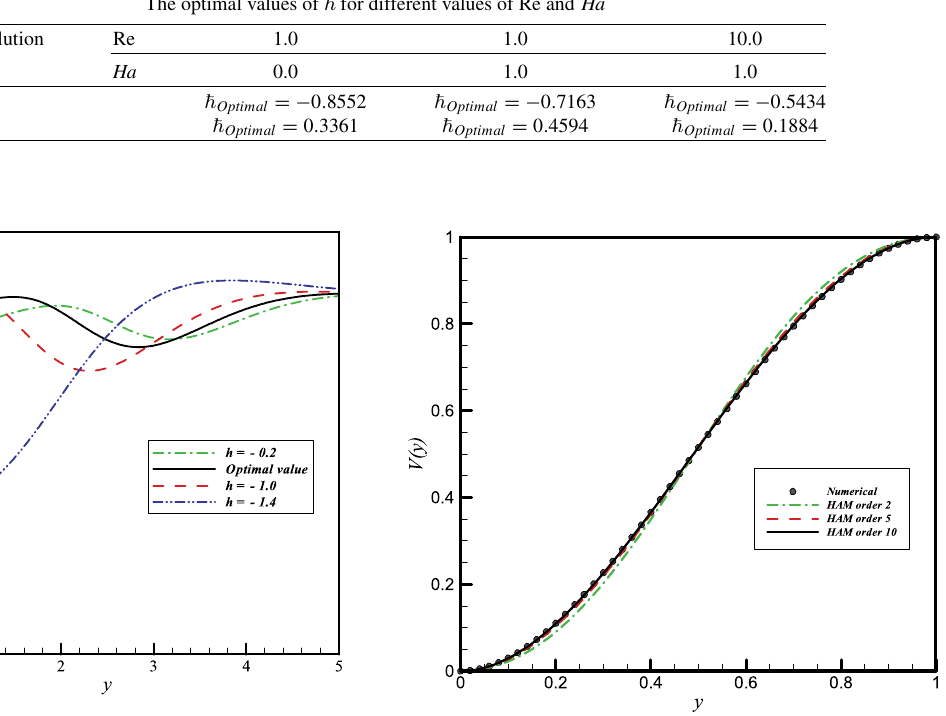
Fig.4. ThebehaviorofthesolutionsRes 10 ( V )obtainedbytheHAM for various (cid:1) when Re = 1 . 0 and Ha = 1 . 0 , [45].